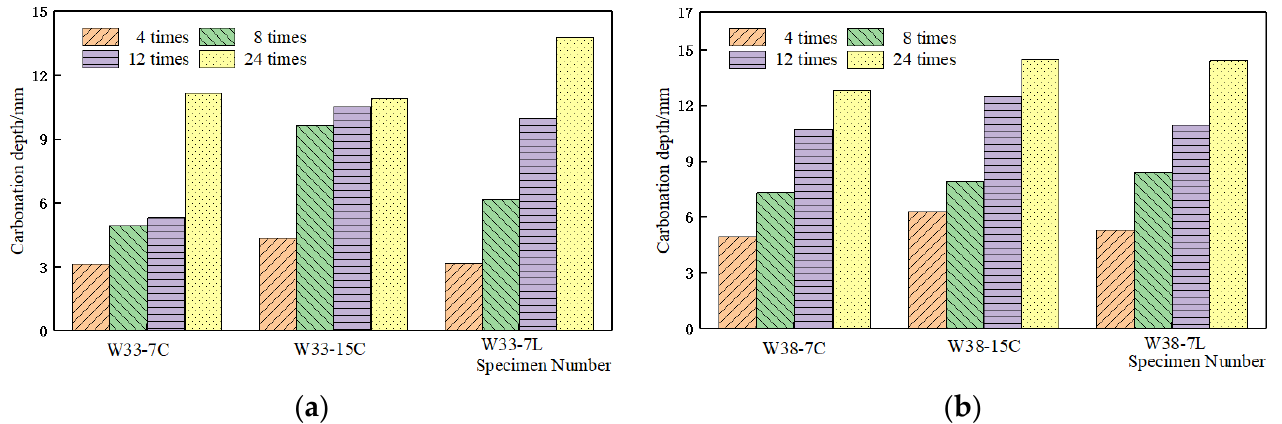
Figure 7. Concrete carbonation depth in different test conditions with different numbers of cycles: ( a ) W/C ratio of 0.33; ( b ) W/C ratio of 0.38.